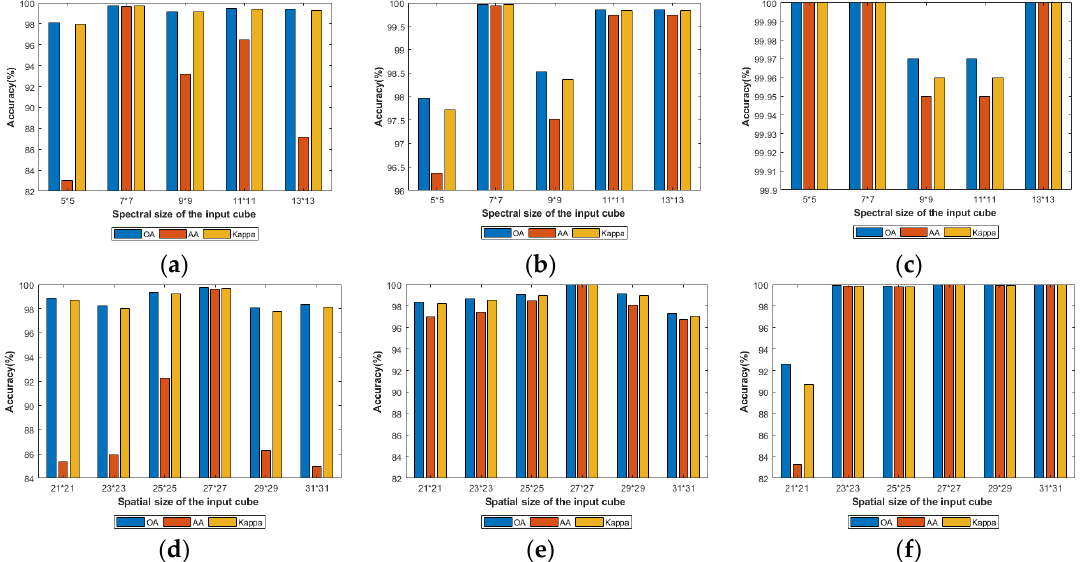
Figure 10. The influence of different spectral and spatial patch sizes. ( a – c ) represent the influence of different spectral patch sizes on IN, KSC and SA respectively. ( d – f ) represent the influence of different spatial sizes patch sizes on IN, KSC and SA